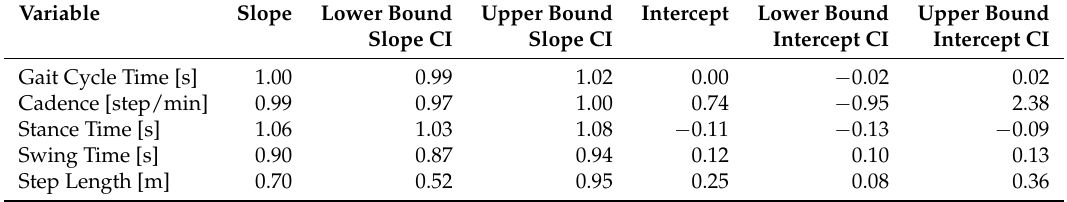
Table 5. Passing–Bablok regression analysis.